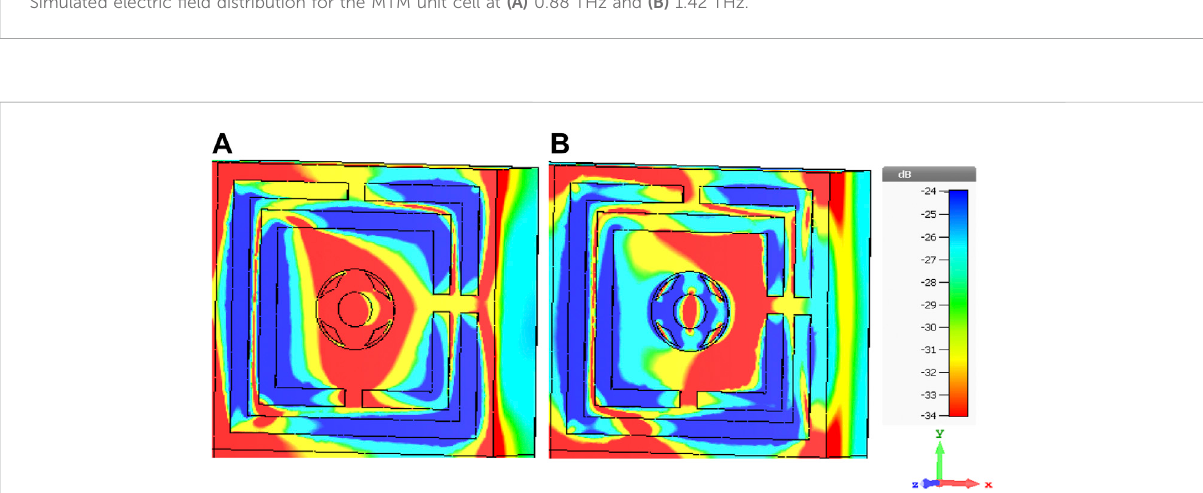
FIGURE 22 Magnetic fi eld distribution for the suggested structure at (A) 0.88 THz and (B) 1.42